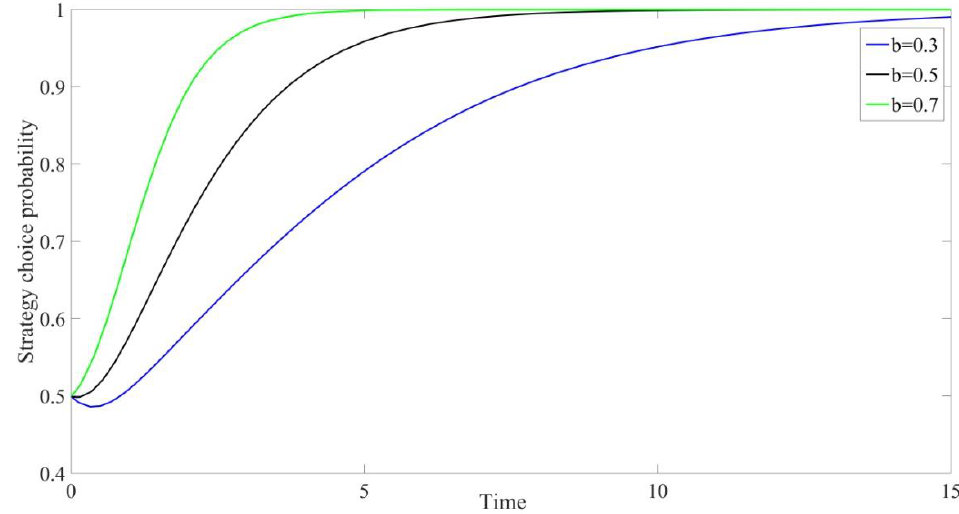
Figure 11. Simulation of different tax incentives intensity.